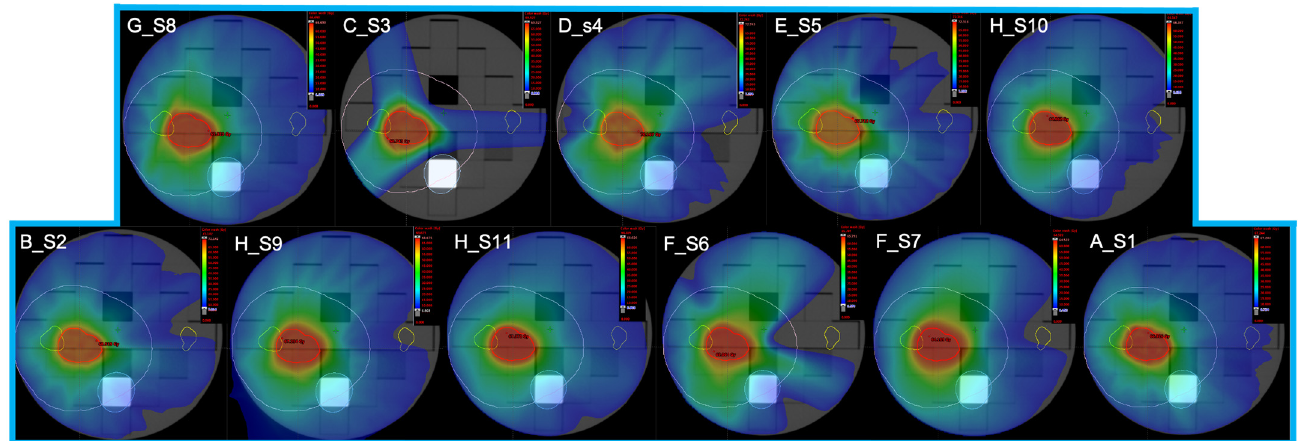
Figure 3. The eleven dose distributions obtained by different techniques, technologies and treatment planning systems, with 1 mm dose grid resolutions.